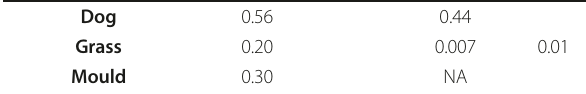
Table 7 Independent associates of lung function and AHR (multivariate analysis)